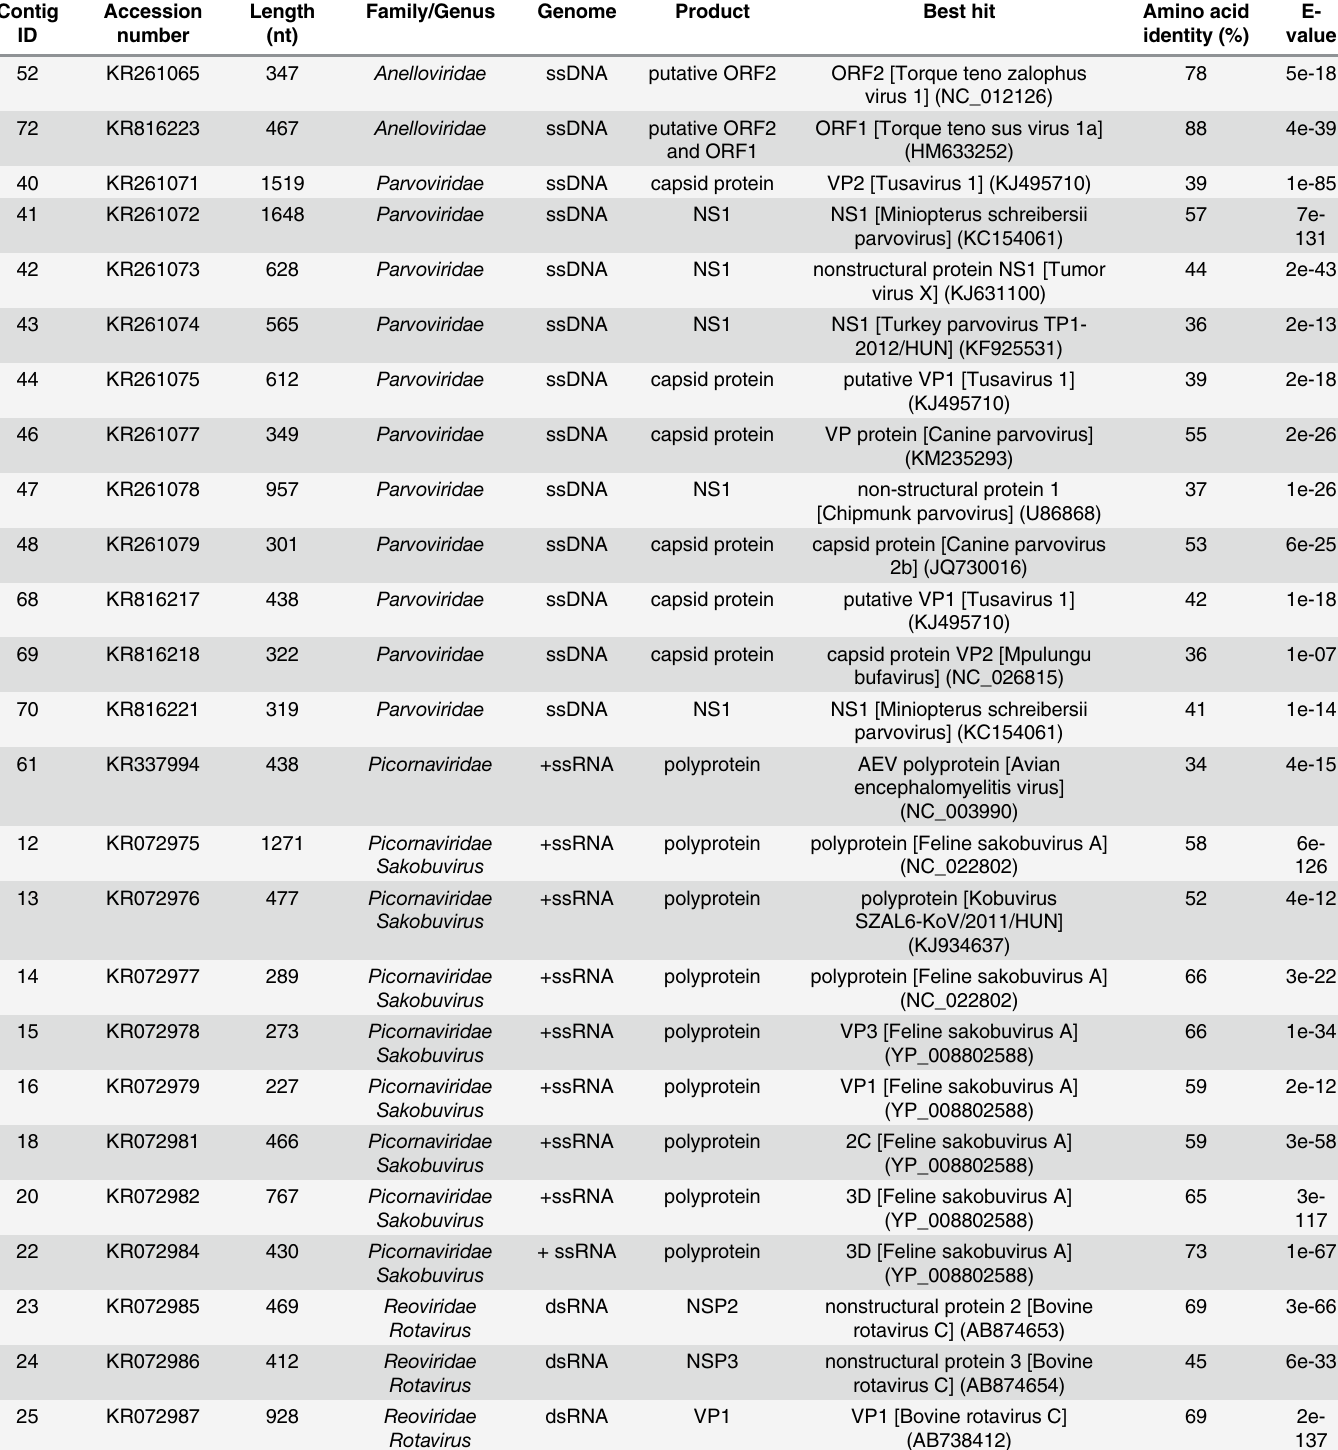
Table 3. Contigs ( > 200bp) with significant BLASTx hits to known eukaryotic viruses obtained from the Subantarctic fur seals (Arctocephalus tropicalis). Contig